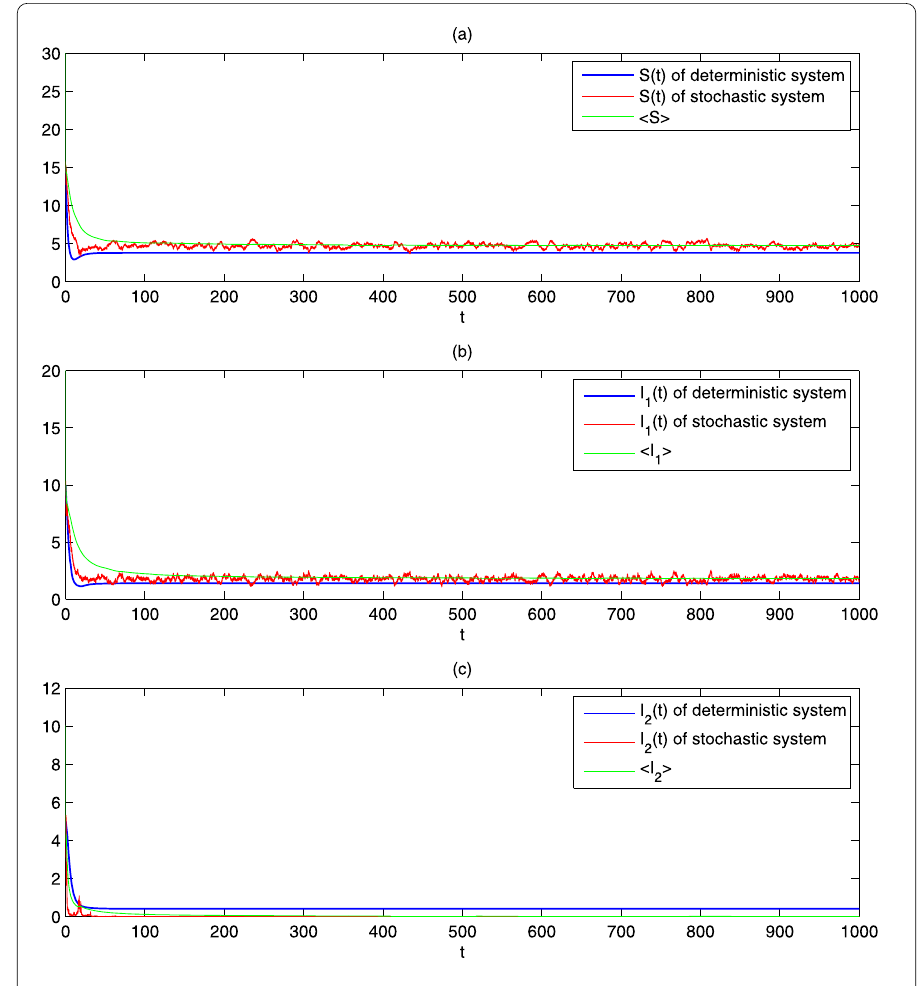
Figure 4 Dynamic behaviour comparisons of S ( t ), I 1 ( t ), I 2 ( t ) in the deterministic and the stochastic SIS system with parameters A = 1, d = 0.1, β 1 = 1.2, β 2 = 1.5, a 1 = 1, a 2 = 1.5, b 1 = 2, b 2 = 1, α 1 = 0.2, α 2 = 0.4, r 1 = 0.3, r 2 = 0.3, σ 1 = 0.2, σ 2 = 1.1. (a) Time series for S ( t ) and (cid:5) S ( t ) (cid:6) . (b) Time series for I 1 ( t ) and (cid:5)